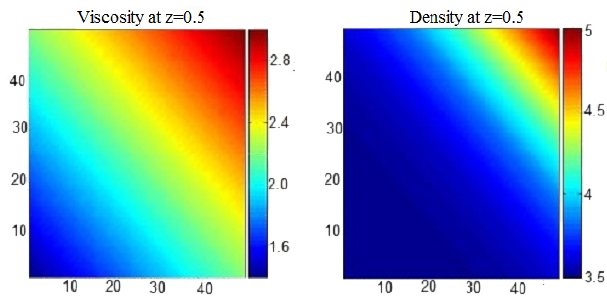
Figure 7. Distribution of viscosity η and exponentially varying vis- cosity, high-viscosity contrast ( η 2 = η 3 = η 4 = 100).